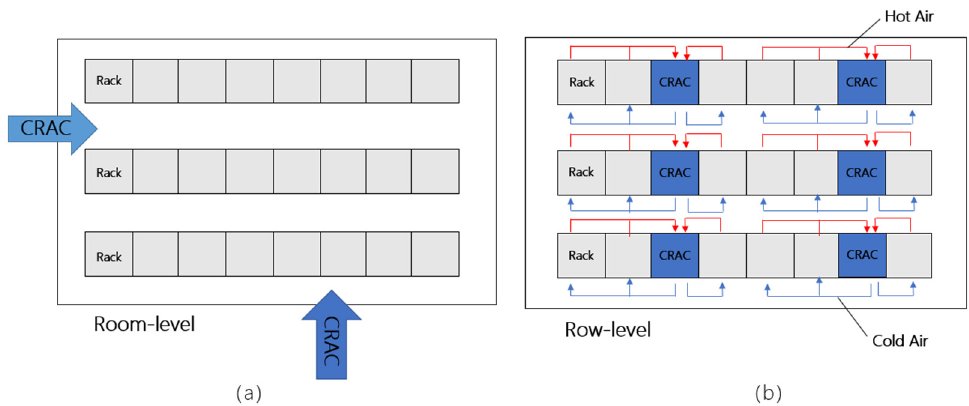
Figure 2. Two types of room cooling systems: ( a ) room-based cooling system; ( b ) row-based cooling system [14].